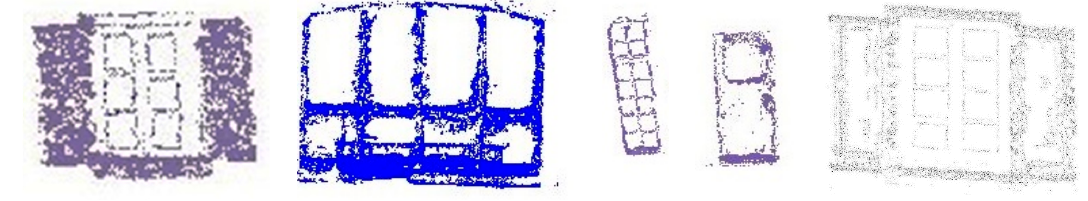
Figure 16. A number of the magnified segregated patches. Table 2. Correctness and Completeness of Window detection via Our Method.